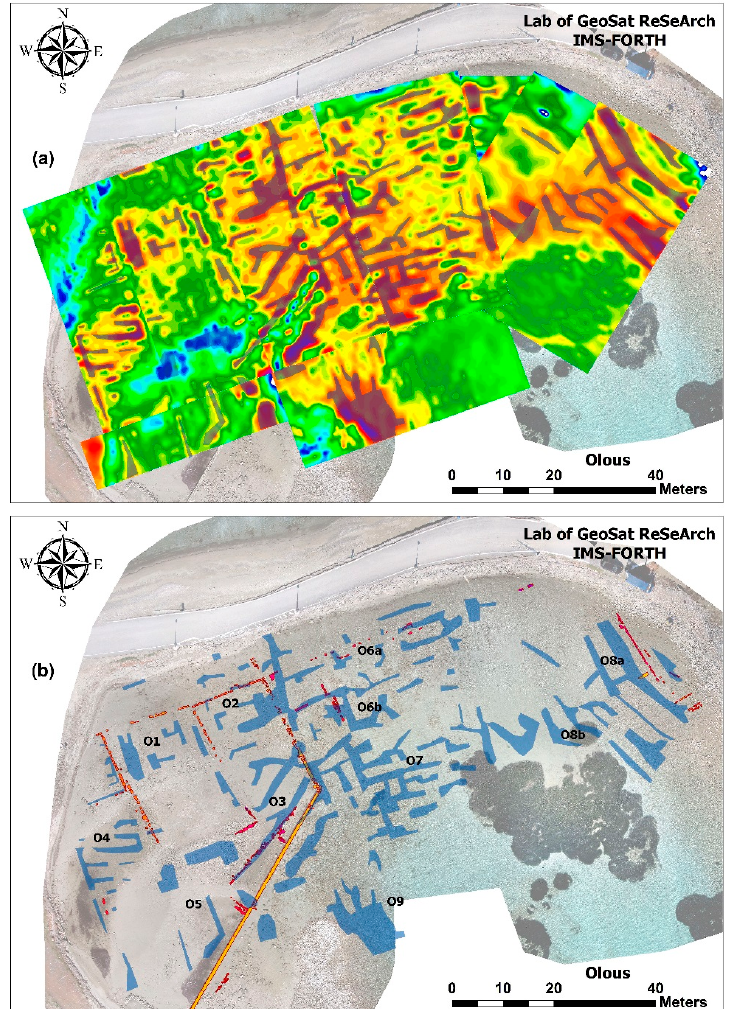
Figure 12. ( a ) Electrical Resistivity Tomography depth slice of 0.0–0.5 m overlaid on the aerial image of Elounda Bay along with the schematic interpretation (purple) of the structures which have been identified; ( b ) Coding of the resistivity anomalies (in light blue) from O1 to O9 defining areas of